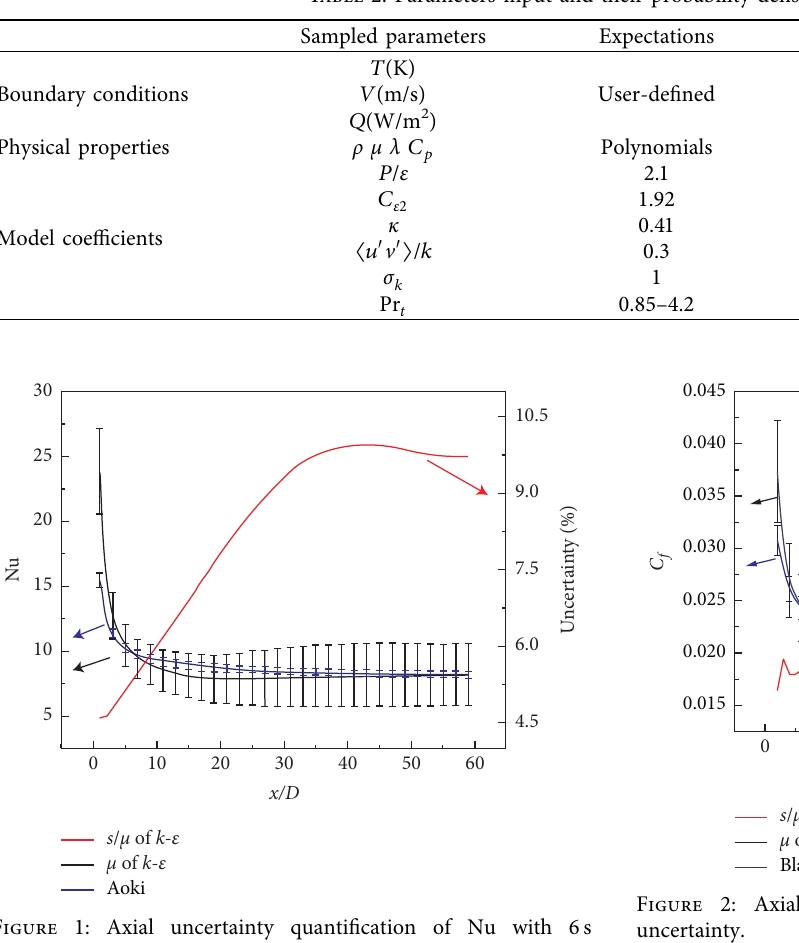
Table 2: Parameters input and their probability density functions.